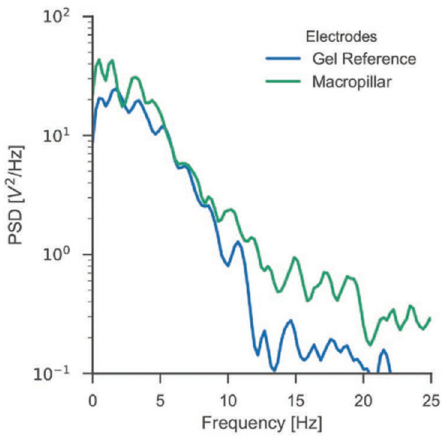
Figure 8. Power spectral density during the eye open